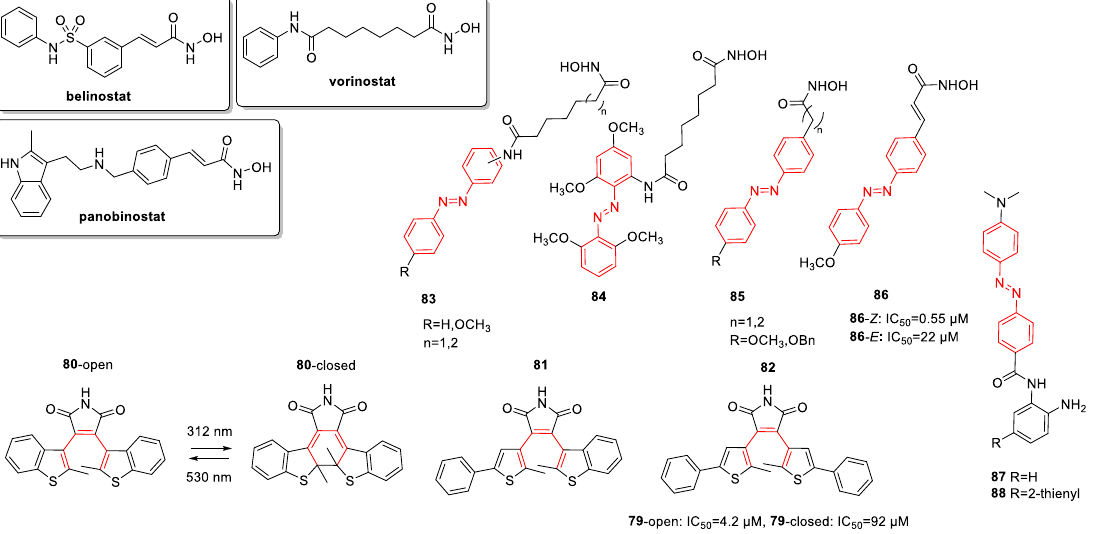
Figure 14. Photoswitchable HDAC inhibitors, the photoswitch unit indicated in red. Feringa and coworkers studied the design of photoswitchable HDAC inhibitors [97] using as starting point vorinostat (SAHA), panobinostat, and belinostat (inhibitors approved for clinical use), and azobenzene as the photoswitch unit. Using structural knowledge on the parent drug ( vorinostat ), two molecular designs were envisaged, introducing the photoswitch either to the cap ( 83 , 84 ) or the linker region ( 85 , 86 ). To study their influence on the photochemical and pharmacological properties, different attachment positions and substitution patterns on the azobenzene were assessed in the former, whereas different linker lengths and types in the latter approach. All novel compounds showed appropriate PSS values (above 75%) upon 365 nm irradiation in DMSO (determined by 1 H NMR spec- troscopy). Depending on the substitution pattern, the half-life of the Z isomer spanned from the minutes to the hours range (determined by UV/VIS spectroscopy at rt, in HDAC assay buffer with 1% DMSO), an important property for auto-inactivation upon therapeutical use. The first screen of activity was performed on class I HDACs (HeLa nuclear extracts), human recombinant class I HDACs (1–3, 8) and HDAC6. Based on the pharmacological results, compound 86 was selected for further studies, due to a potent activity of the Z state (HDAC1 ( E ): IC 50 = 0.66 µ M, HDAC1 ( Z ): IC 50 = 0.080 µ M; HDAC2 ( E ): IC 50 = 22 µ M, HDAC2 ( Z ): IC 50 = 0.55 µ M, HDAC3 ( E ): IC 50 = 0.32 µ M, HDAC3 ( Z ): IC 50 = 0.071 µ M; vorinostat : HDAC2—IC 50 = 0.18 µ M), appropriate Z / E activity ratio and reversible action upon illumination. Cytotoxicity of selected compounds was measured in a cellular assay (cell viability of HeLa cells) in both isomeric forms. For 86 , in line with the HDAC assays, the Z isomer showed higher